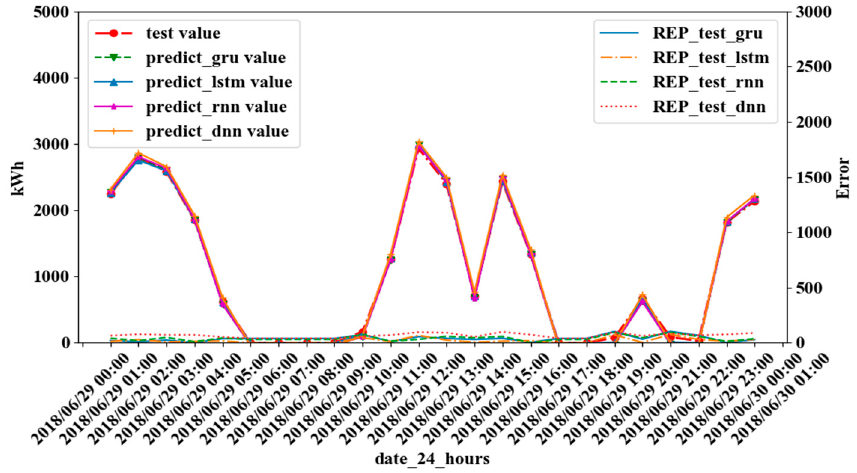
Figure 7. Predictions and real error points (REP) of the test stage.